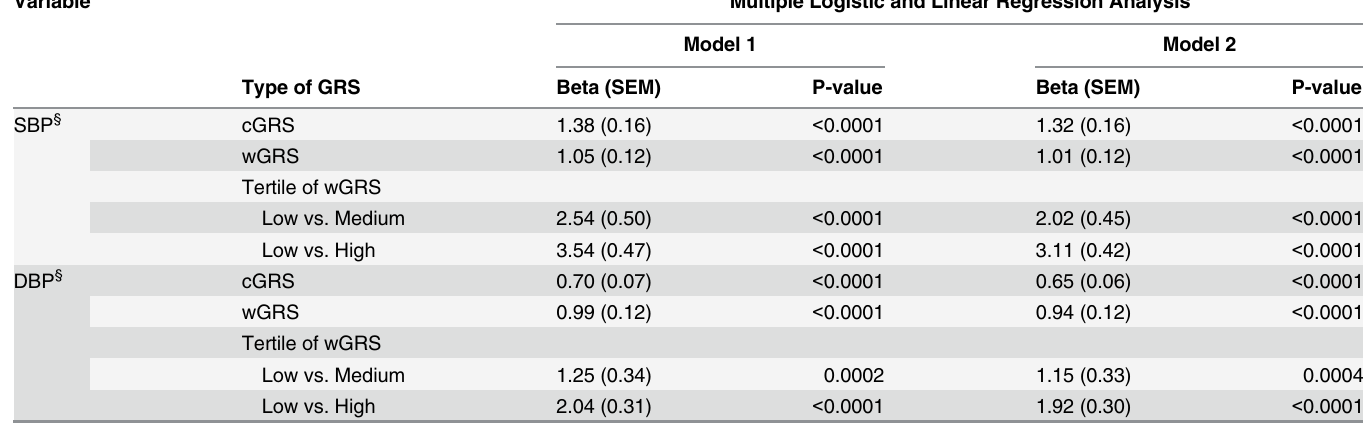
Table 4. Association between GRS and DBP and SBP at